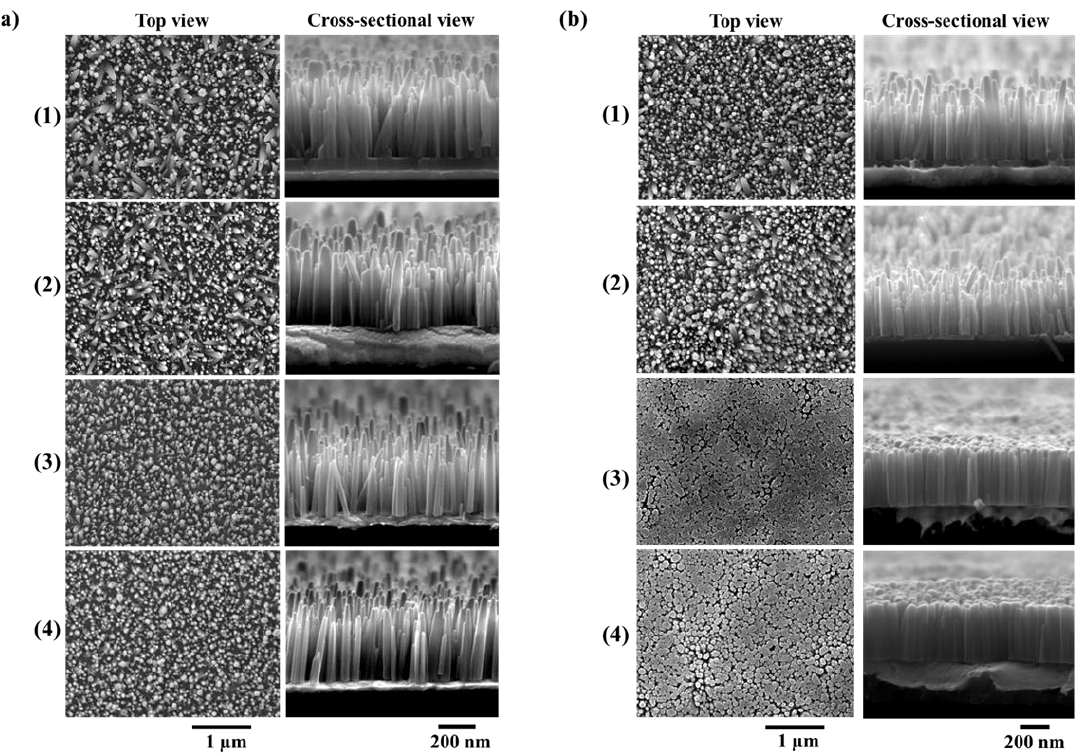
Figure 4. Scanning electron microscope (SEM) images of ZnO NWs grown on ( a ) non-annealed and ( b ) annealed ZnO seed layers with thicknesses of (1) 100, (2) 50, (3) 10, and (4) 5 nm. Table 2. ZnO NW morphology depending on the thickness and heat treatment of the ZnO seed layer. Thickness